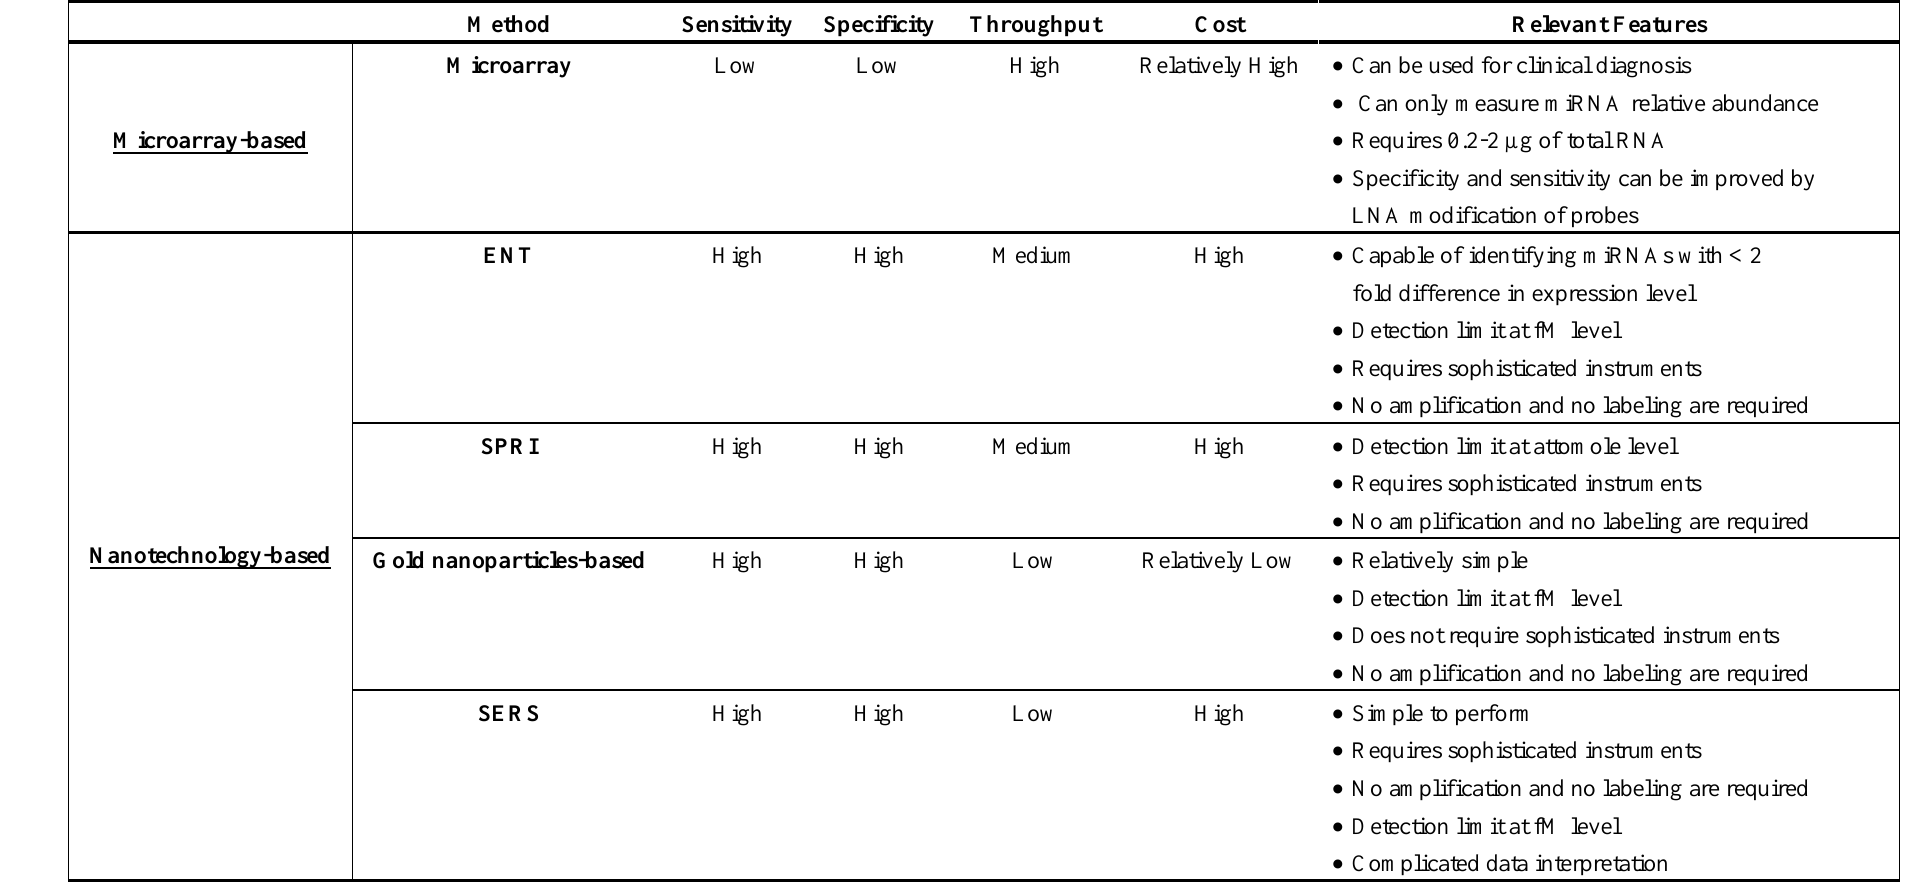
Table 2. Comparison of various methods for miRNA